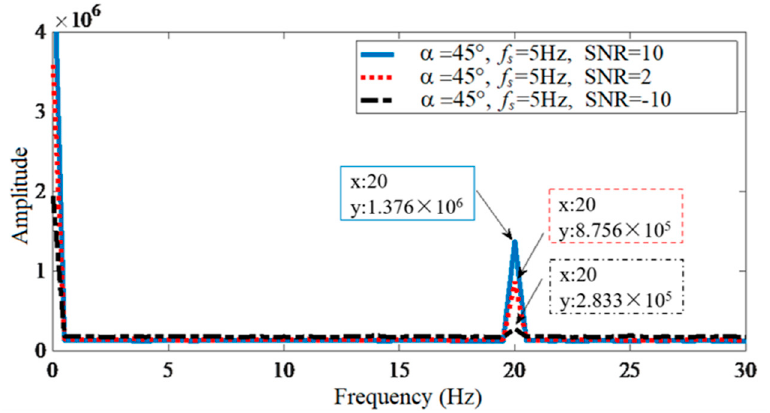
Figure 4. Variation of the amplitude of the 2D Fourier spectrum of the time − frequency image and the time repetition frequency.